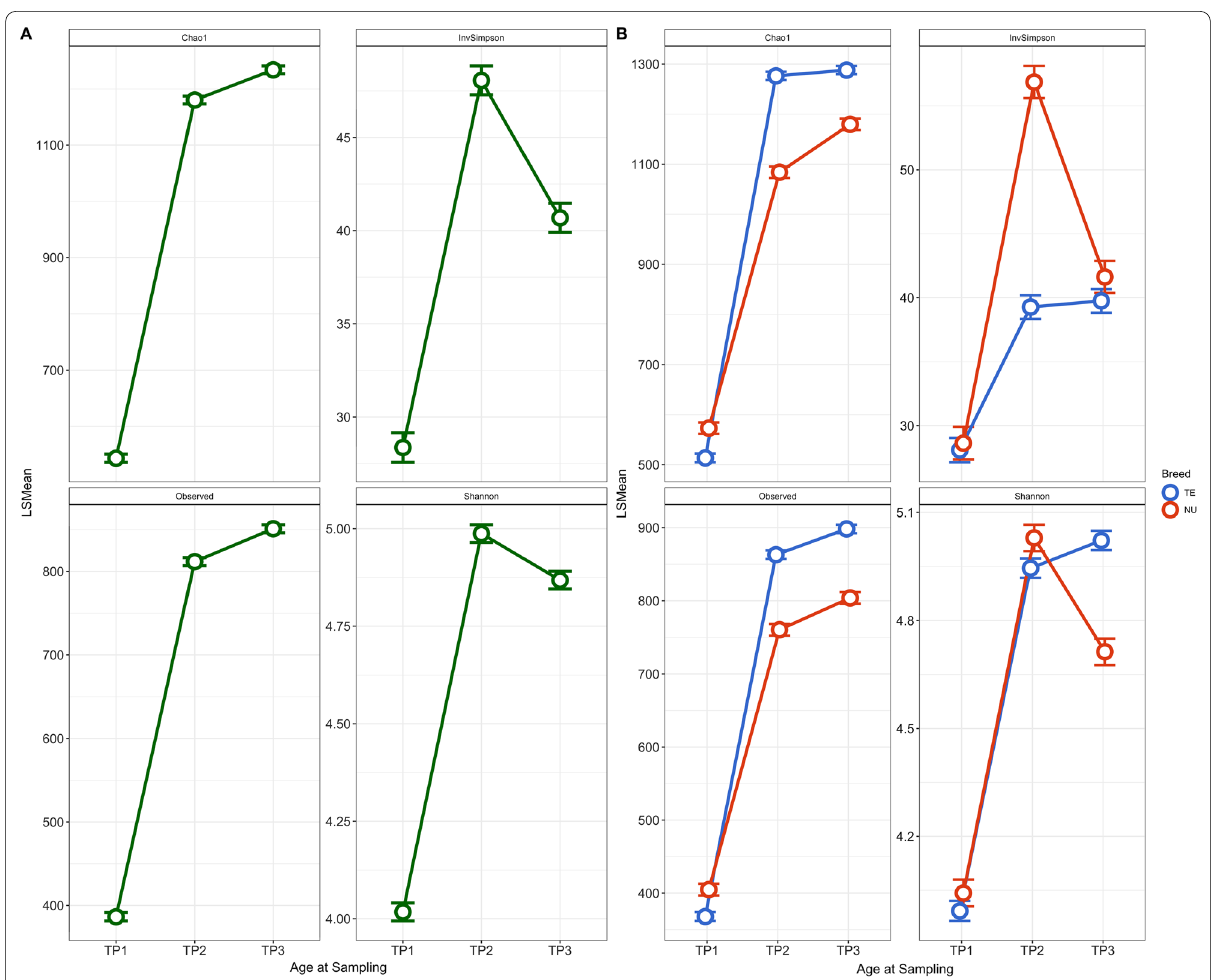
Fig. 2 Measurements of fecal microbiome alpha diversity overall and for two systems at three time points. Measurements at OTU level using the Observed, Chao1, Shannon, Simpson, and Inverse Simpson indices (least squares means and Crossbred (TE) ( b ) at three time points: weaning (TP1), mid test (TP2), and off test (TP3) of the feeding